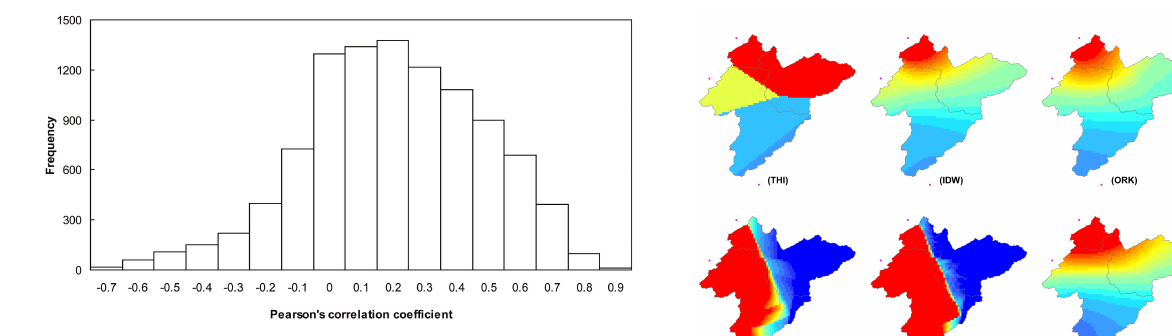
Fig. 8. Histogram of Pearson’s correlation coefficients computed from the correlation between daily rainfall (1976–2005) and altitude extracted from DEM. Fig. 9. Annual mean rainfall of the Ourthe and Ambleve catch- ments, generated using six different algorithms and 4